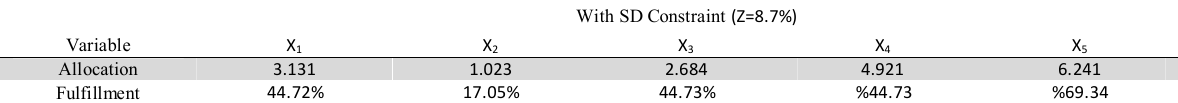
With SD Constraint (Z=8.7%)